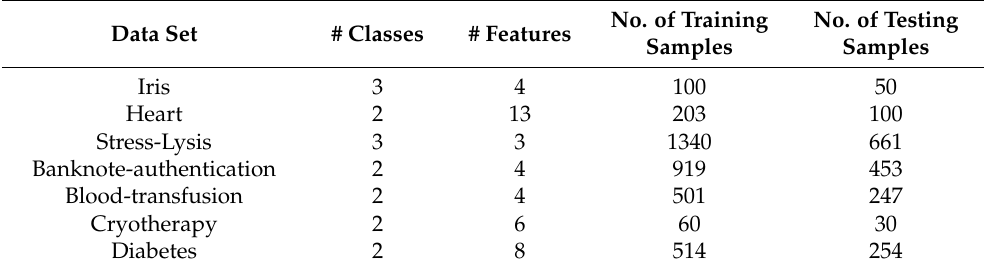
Table 6. Description of used dataset.